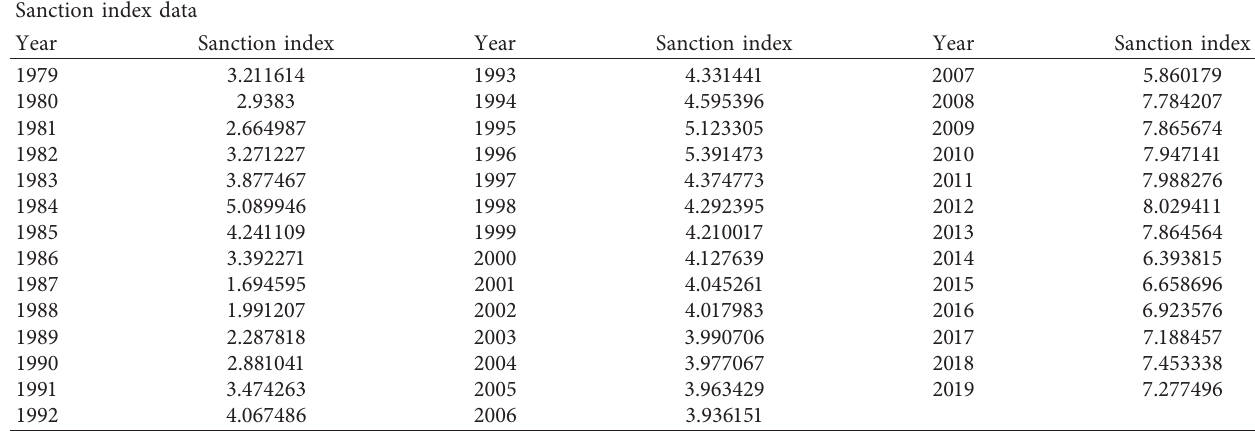
Table 4: Sanction index data for Iran.